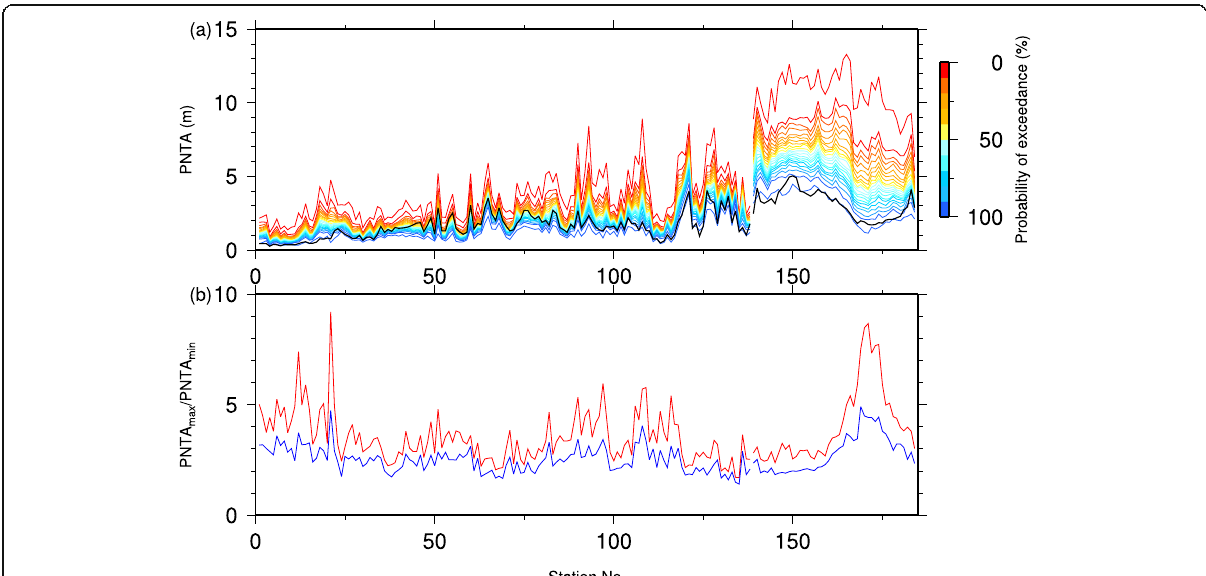
Fig. 5 Statistical characteristics of peak nearshore tsunami amplitude (PNTA). a Conditional probabilities of exceedance of PNTA at each site for stochastically generated heterogeneous slip distributions. Station numbers correspond to the locations shown in Fig. 4. The black line is PNTA computed for a uniform slip distribution. b Ratios of maximum to minimum PNTA values at each site (red line). The blue line is the ratio computed for the middle 95% of scenarios